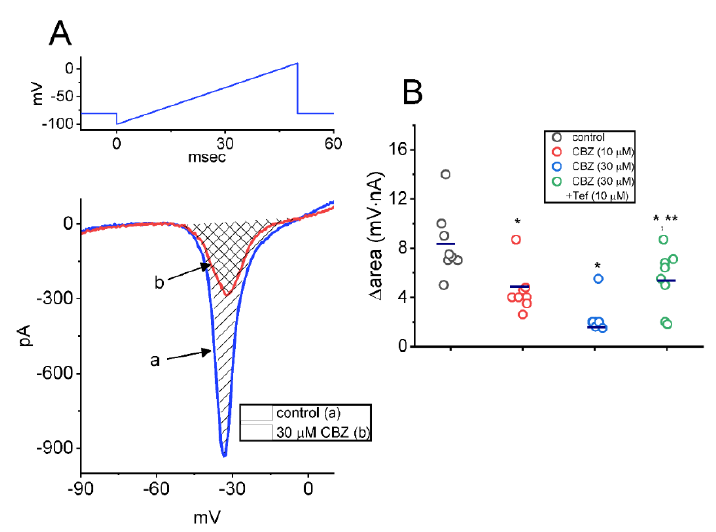
Figure 3. Inhibitory effect of CBZ on window I Na ( I Na(W) ) evoked by abrupt ascending ramp voltage (V ramp ) in Neuro-2a cells. This set of whole-cell current recordings was conducted with the examined cell voltage-clamped at − 80 mV, and we thereafter imposed the V ramp from − 100 to +10 mV for a duration for 50 ms on the cell. ( A ) Representative current traces were acquired in the control period (a, blue color) and during the exposure to 30 µ M CBZ (b, red color). The voltage clamp protocol applied is depicted in the upper part, the downward deflection shows the appearance of inward current (i.e., instantaneous I Na(W) ), and the shaded areas indicate the ∆ area of I Na(W) evoked by short ascending V ramp . ( B ) Summary graph demonstrating the effect of CBZ (10 or 30 µ M), and CBZ plus tefluthrin (Tef) on the ∆ area of I Na(W) (mean ± SEM; n = 8 for each point). Each horizontal bar indicates the mean value. The ∆ area (i.e., shaded region in ( A )) was calculated at the voltage ranging between − 50 and +10 mV during the upsloping V ramp . The analysis was made by one way ANOVA (F value = 4.8; p < 0.05). * Significantly different from control (t value = 3.2; p < 0.05) and ** significantly different from CBZ (30 µ M) alone group (t value = 3.3; p <